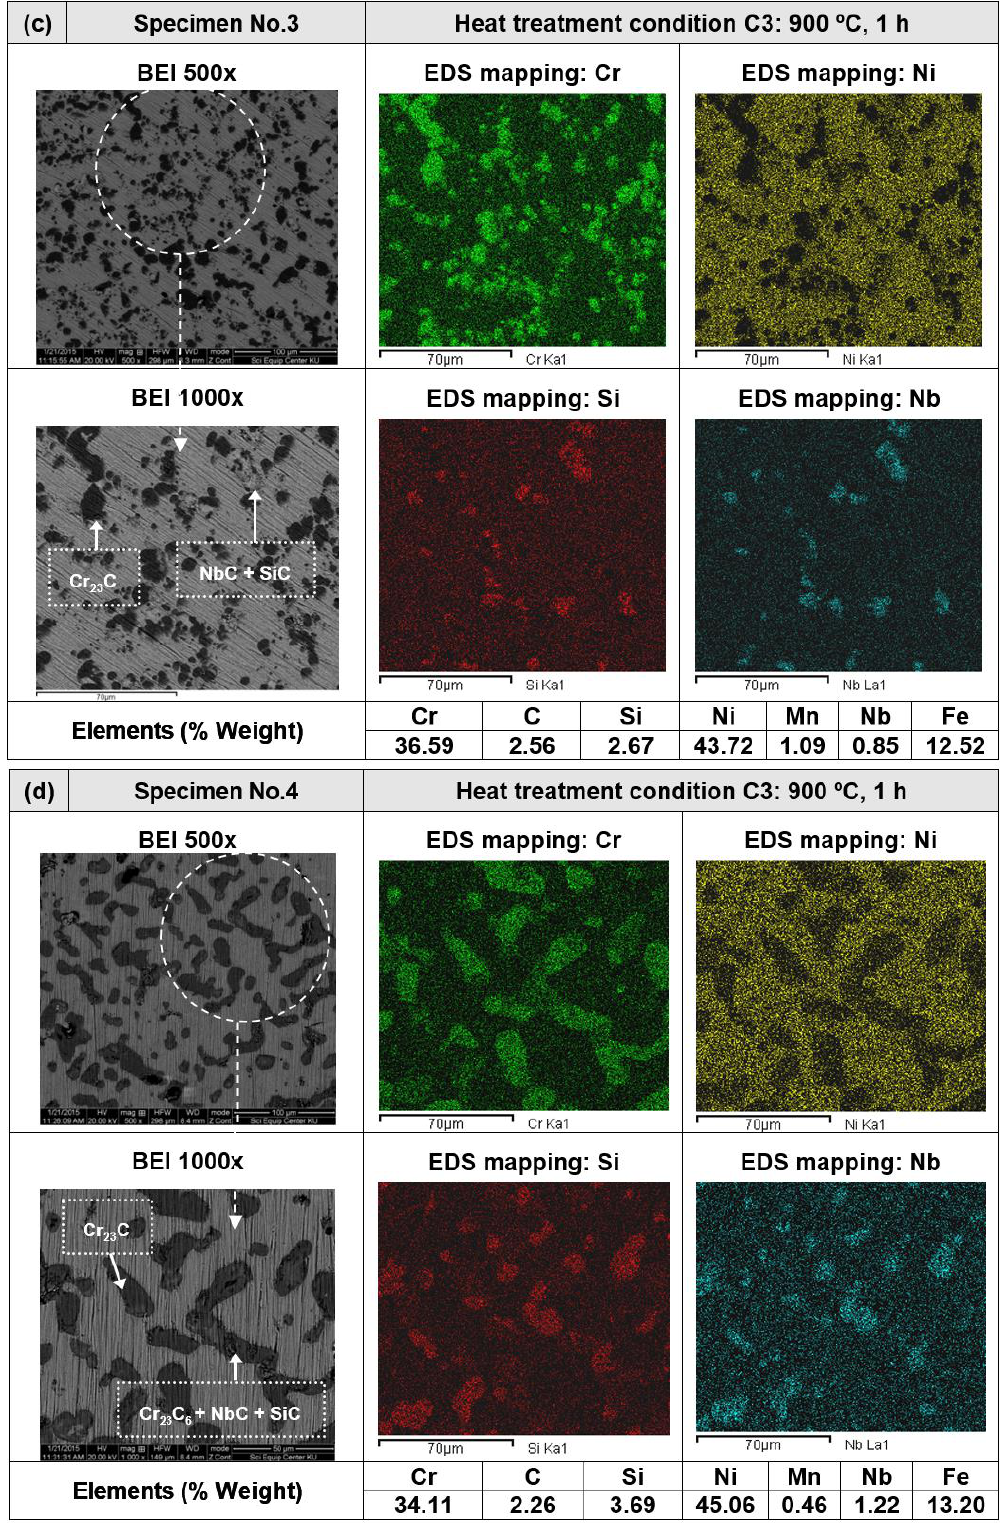
Figure 7. BEI and EDS mapping of the 35Cr-45Ni-Nb specimens after 1 h of thermal heat treatment at 900 ˝ C: ( a ) Specimen No. 1; ( b ) Specimen No. 2; ( c ) Specimen No. 3; ( d ) Specimen No.